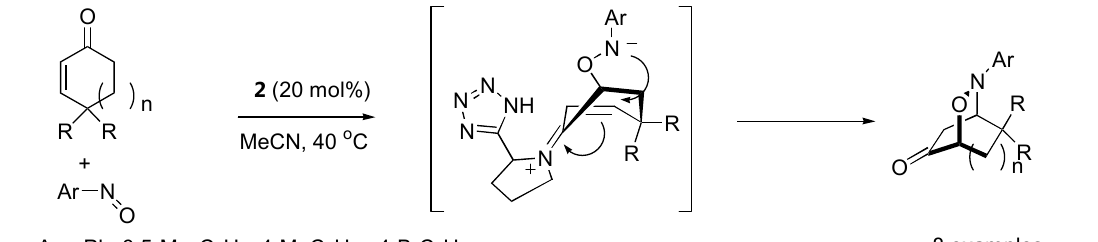
Figure 23. Tandem aminoxylation-intramolecular Michael addition of aminoxylated products derived from unsaturated aldehydes